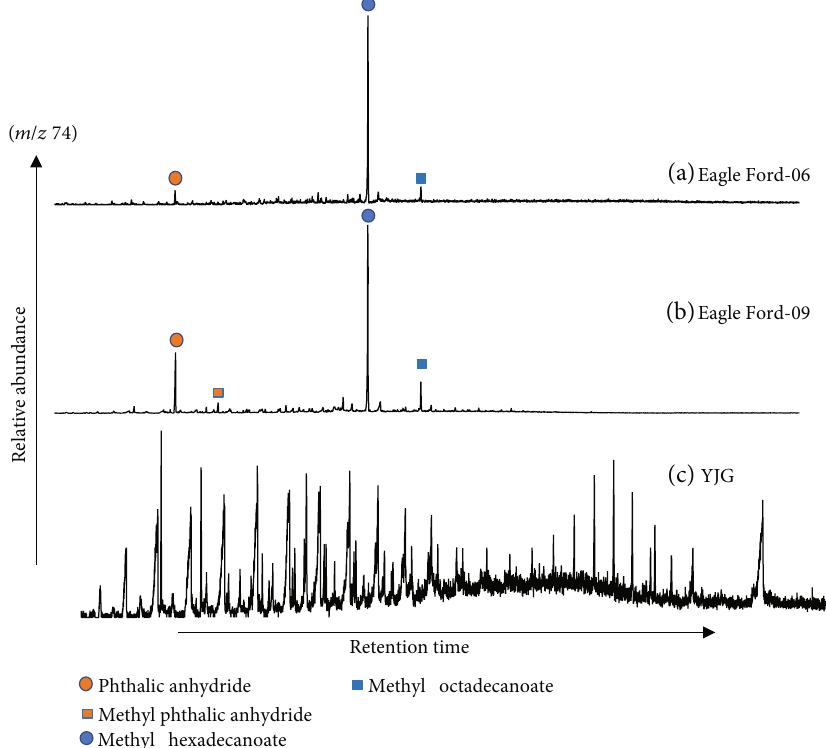
Figure 7: m / z 74 mass chromatograms of the organic compounds in diethyl ether ((a) Eagle Ford-06, (b) Eagle Ford-09, and